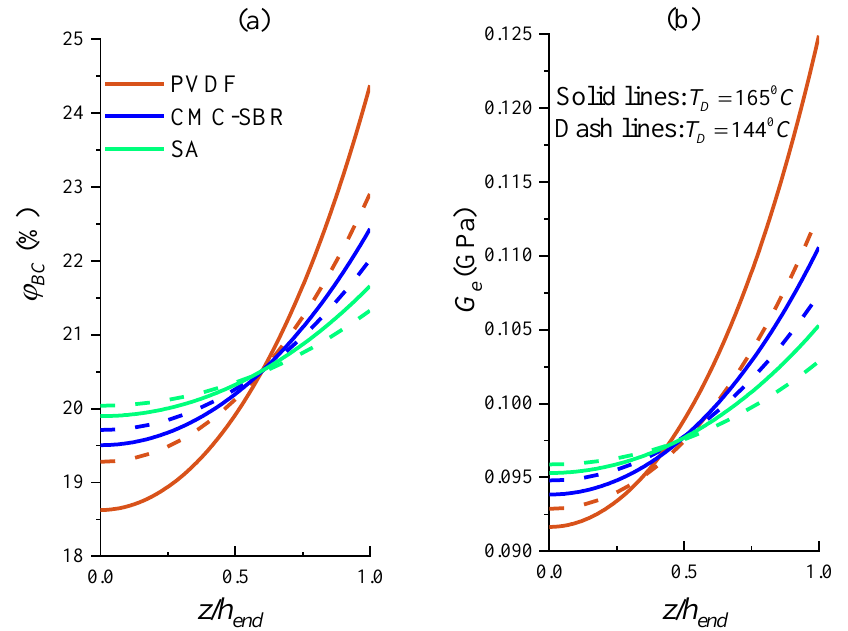
Figure 4. ( a ) Volume fraction distribution, ϕ BC of BC and ( b ) shear modulus, G e of dried NMC based composite across electrode thickness.